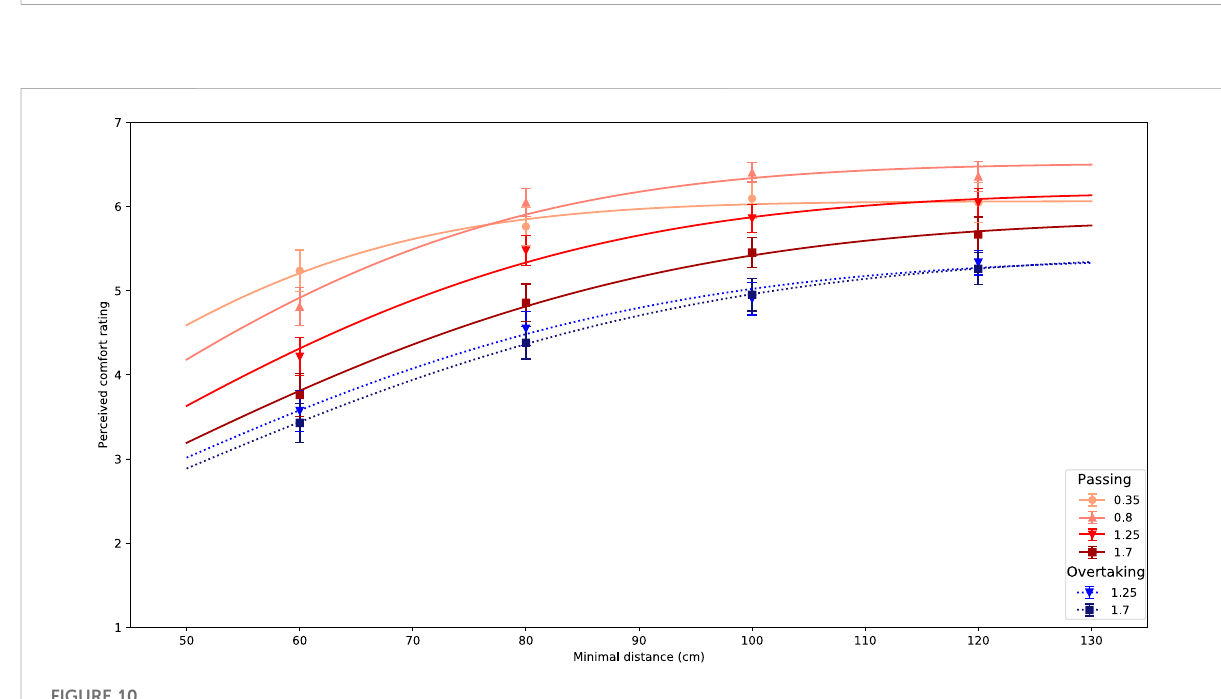
FIGURE 10 Fitted inverted Gaussians for all combinations of scenarios and speed. Error bars represent Standard